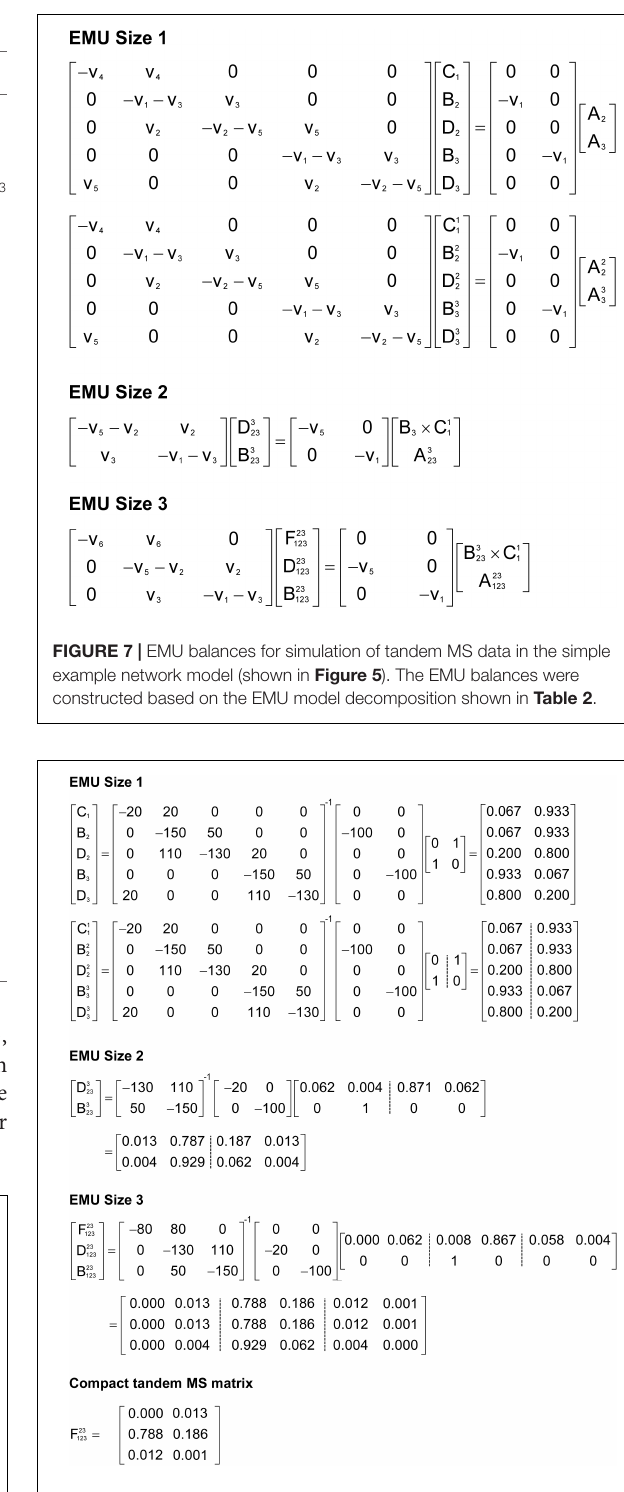
FIGURE 8 | Numerical solution of the EMU balances for the simple example network to simulate tandem MS data for metabolite F (parent fragment C1–C3, daughter fragment C2–C3). For this simulation, the fluxes shown in Figure 5 were used and metabolite A was assumed to be 100% 13 C-labeled at the second carbon